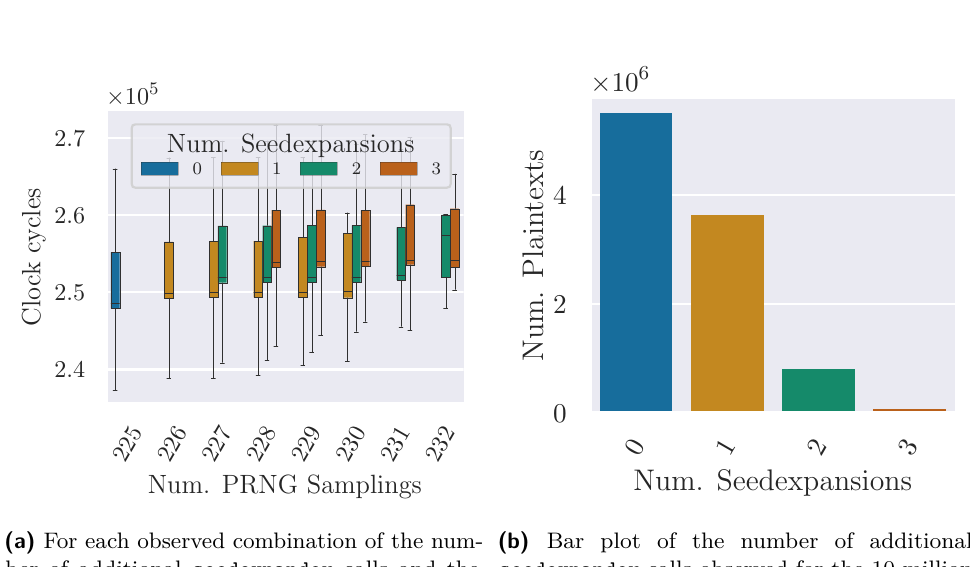
Figure 3: Decapsulation timings and frequency of different timing behaviors. We observe that the running time of the decapsulation function is proportional to the number of seedexpansions and that more seedexpander calls are rare. The left figure shows a standard box plot with the median indicated within the box, which also shows the quartiles. The whiskers extend to show 1 . 5 times the interquartile